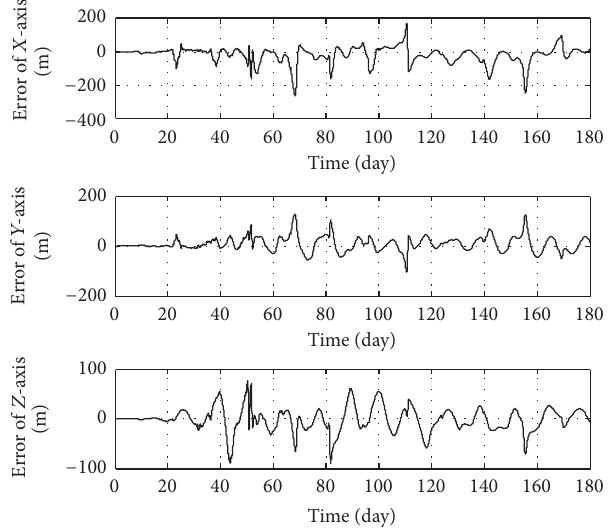
Figure 7: The AOD position error of 𝐿 1 using FMF.